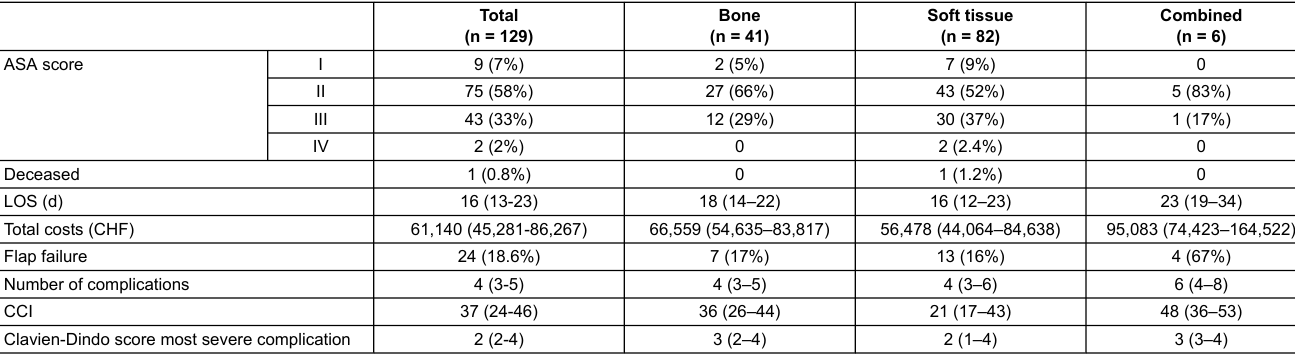
Table 3: Patient outcomes by flap type (bone flap vs soft tissue flap) (n =